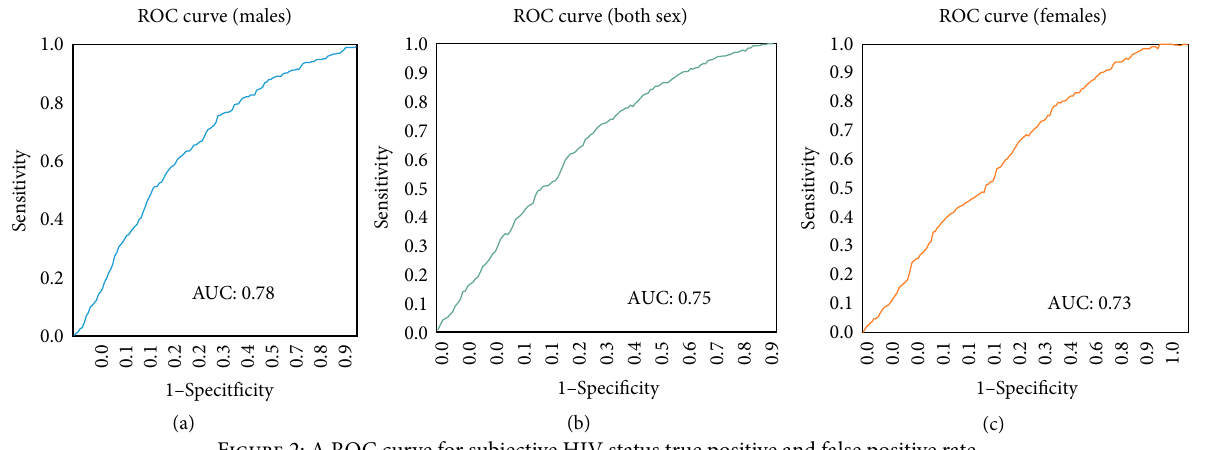
Figure 2: A ROC curve for subjective HIV status true positive and false positive